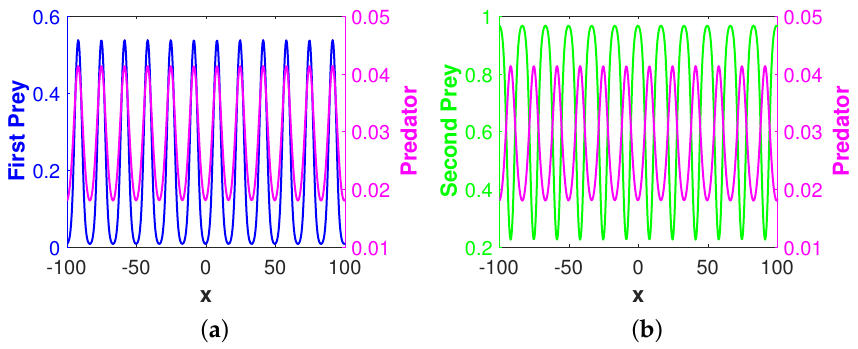
Figure 4. Correlation of densities among two prey and one predator species at a particular instant of time when the patterns are stationary in time. Left panel ( a ) shows the density correlation between first prey and predator species and right panel ( b ) shows the same between second prey and predator species. Numerical simulation has been performed for the same parameter values as in the Figure 3 over the one-dimensional spatial domain [ − 100,100 ] .